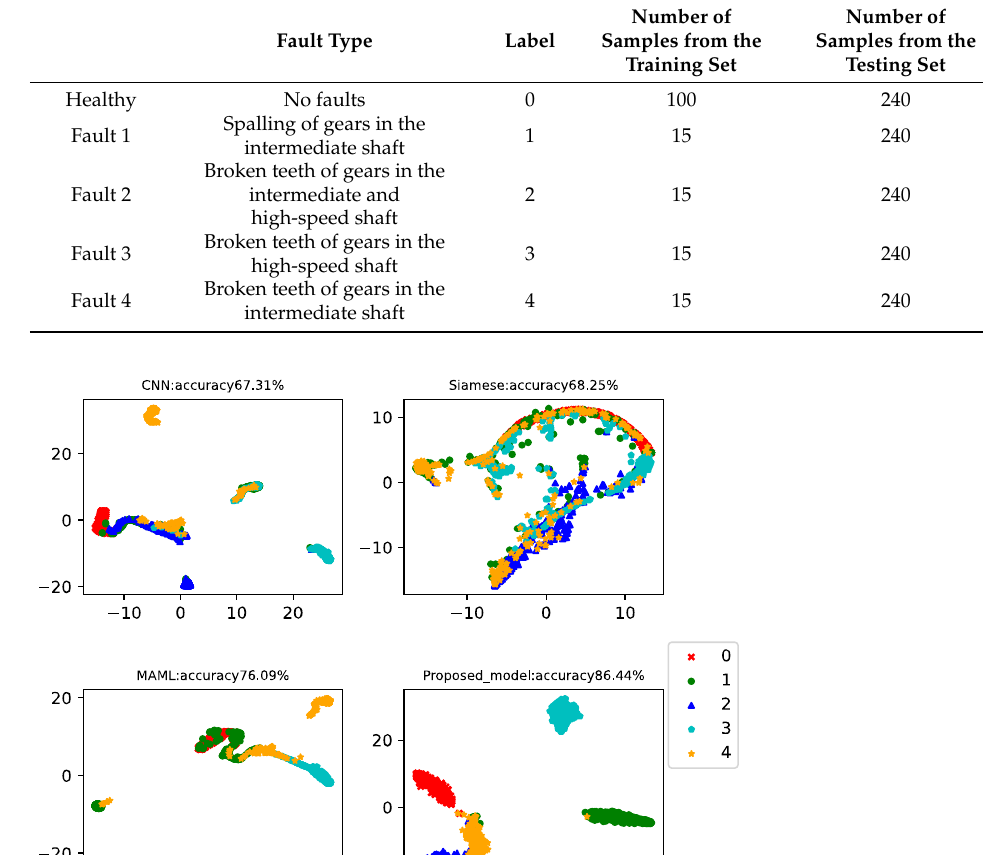
Table 5. Fault description of wind turbine gearbox.